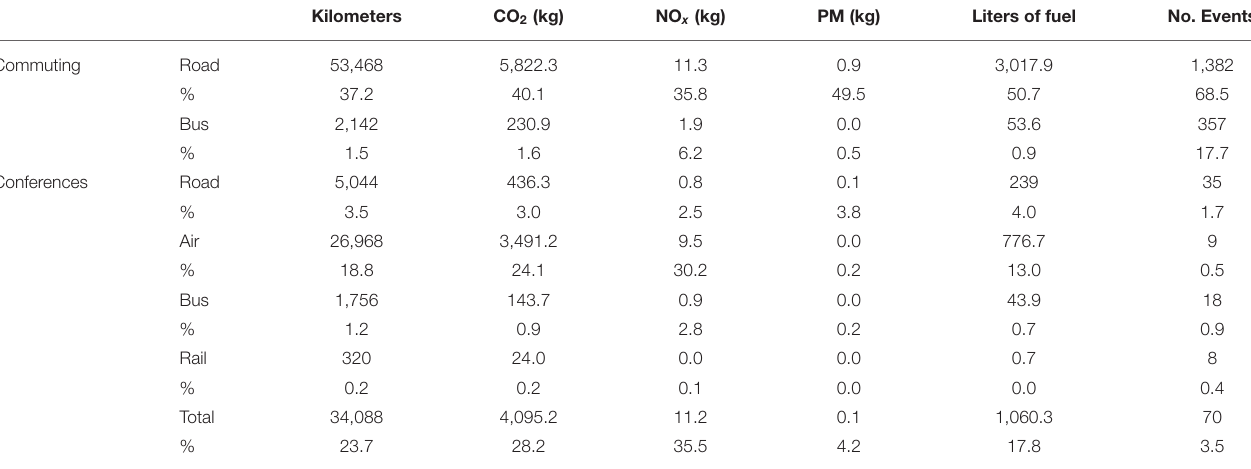
TABLE 6 | The distance traveled, the approximate emissions, fuel use, and number of events associated with the commuting and conference categories considered. Kilometers